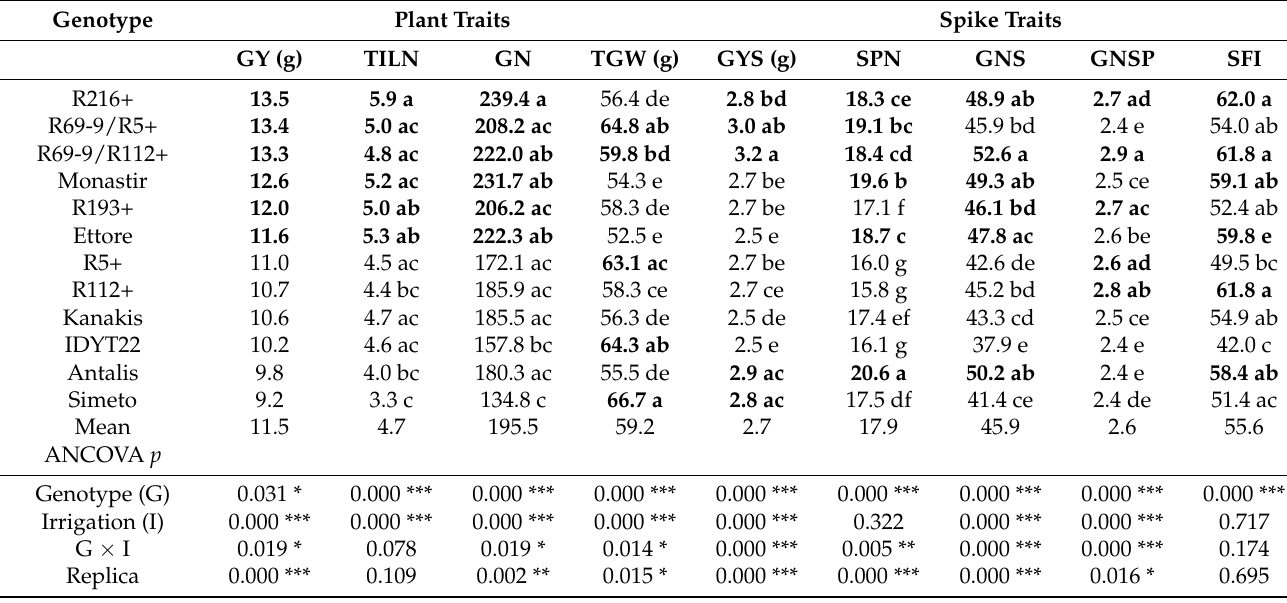
Table 4. Mean values and ANOVA of yield and yield-related traits recorded in 2020 for 7el 1 L + 7el 2 L and 7el 1 L + 7EL durum wheat RLs and control cultivars. Genotypes are ordered from the best to the least productive one according to GY. Genotype Plant Traits Spike